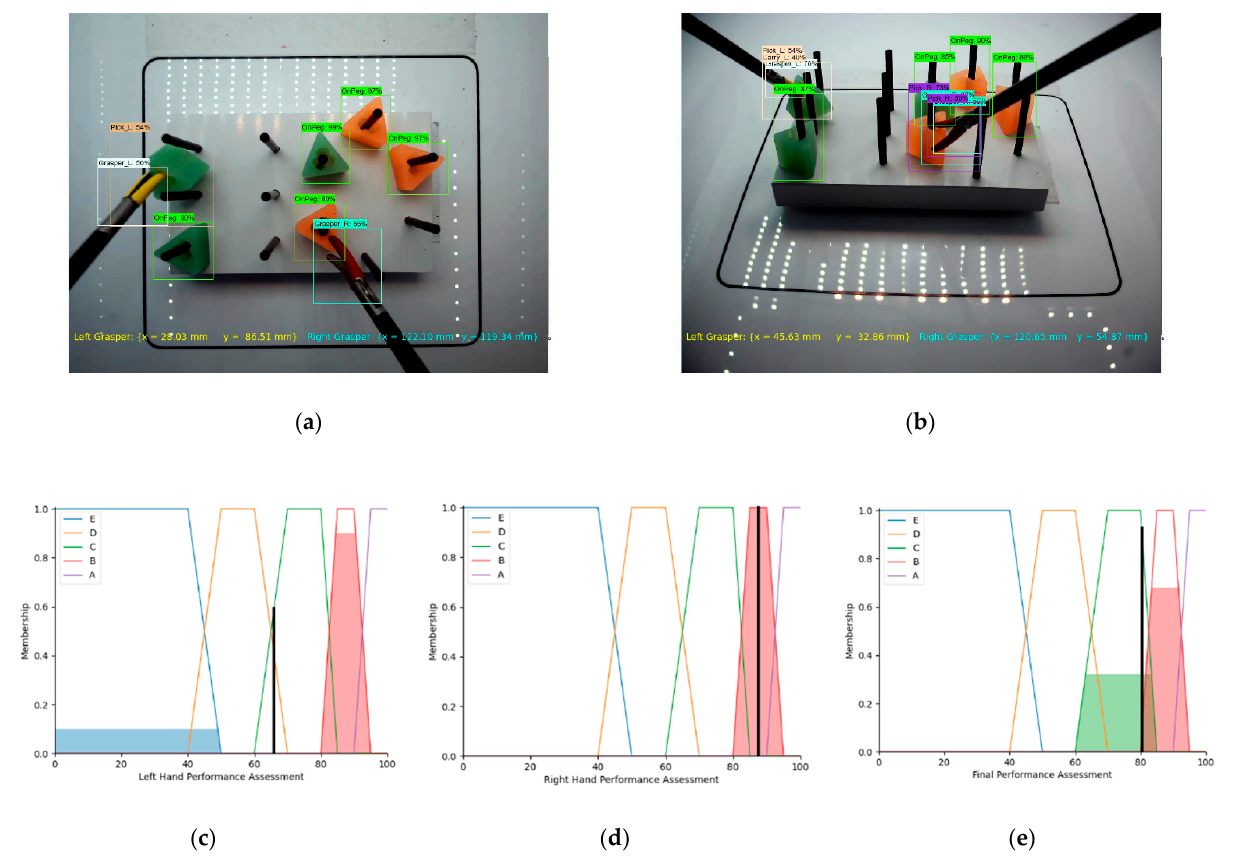
Figure 10. ( a , b ) Object detection and measurement metric results in top and front cameras, ( c ) SLHPA, ( d ) SRHPA, ( e ) final assessment FPA (good performance).